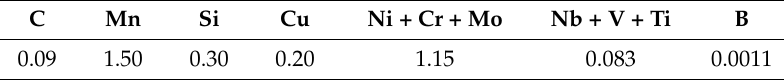
Table 1. Chemical composition of the experimental steel (wt %).